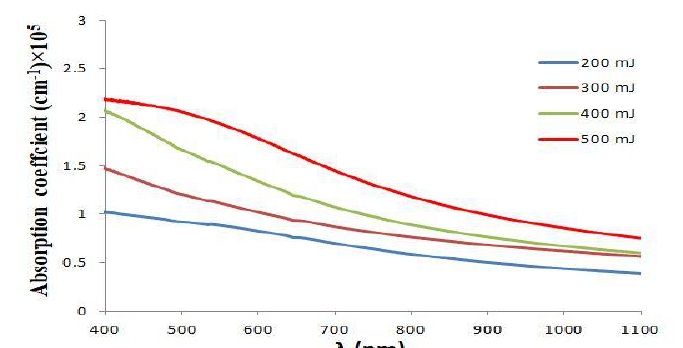
Fig.5: Absorption coefficientα of PbS nanostructure deposited at different laser energies as a function of